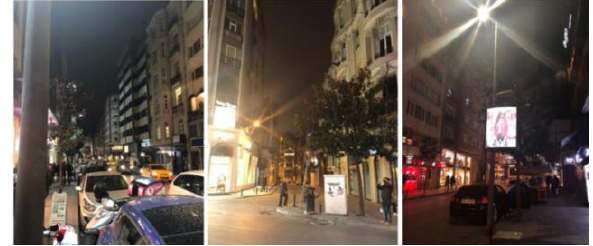
Figure 9. Inadequate Lighting (photo by authors)